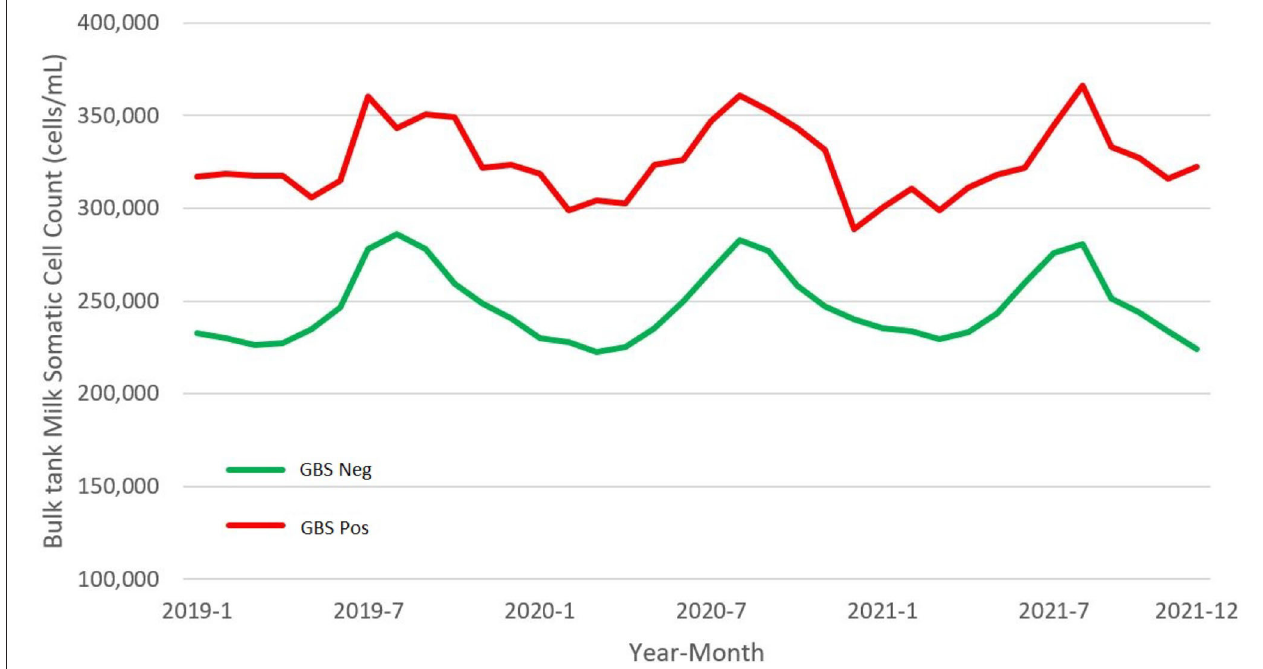
FIGURE 4 | Monthly mean of bulk tank milk (BTM) somatic cell counts (SCCs) in dairy herds positive and negative for S. agalactiae (GBS) of the Emilia-Romagna region, 2019–2021.